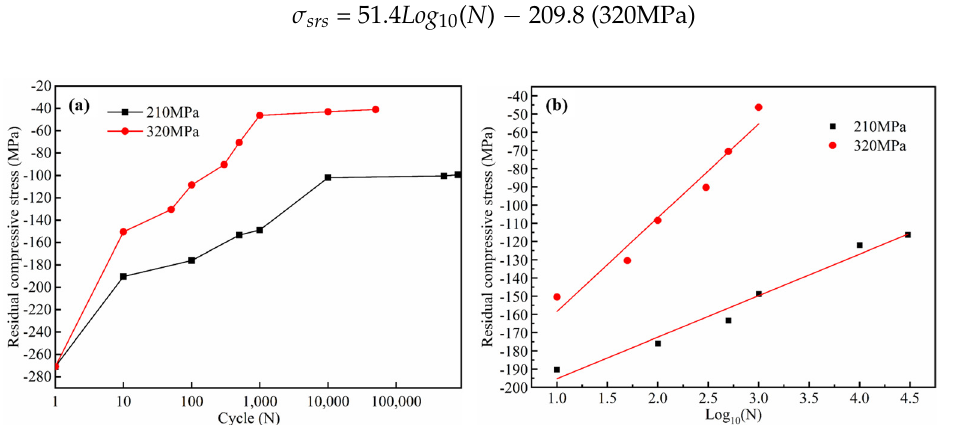
Figure 10. Residual stress at the surface vs. number of cycles at different stress amplitudes: ( a ) normal cycles; ( b ) logarithm of cycles.